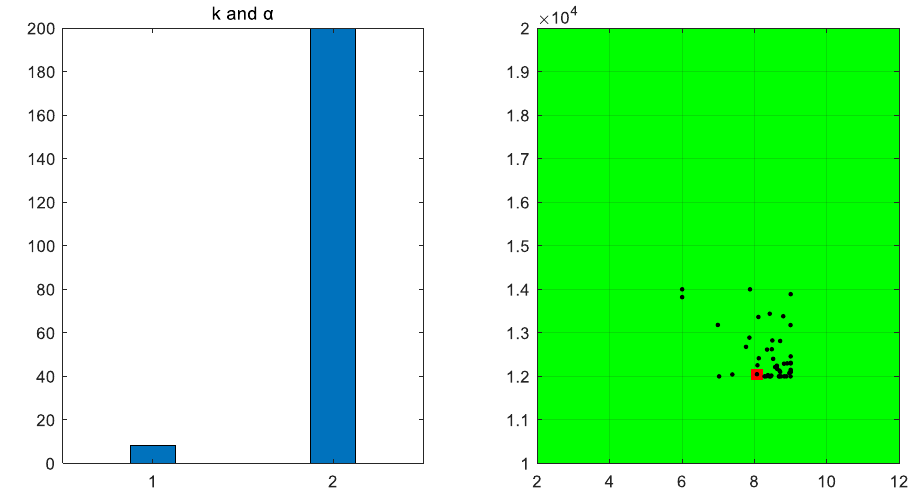
Figure 11. Optimal particle value and particle distribution in ISPO search.